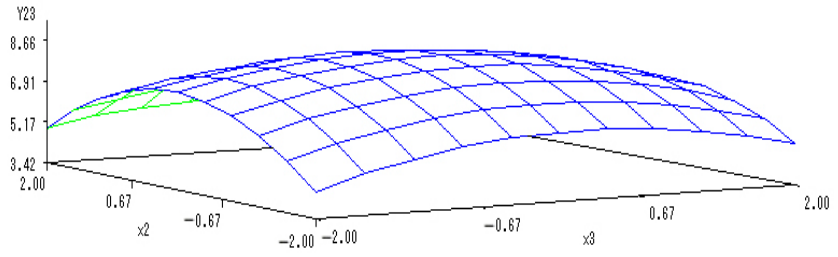
Figure 7. The 3-D map of mutual effect of P and K fertilizers on the content of soluble proteins in melon.